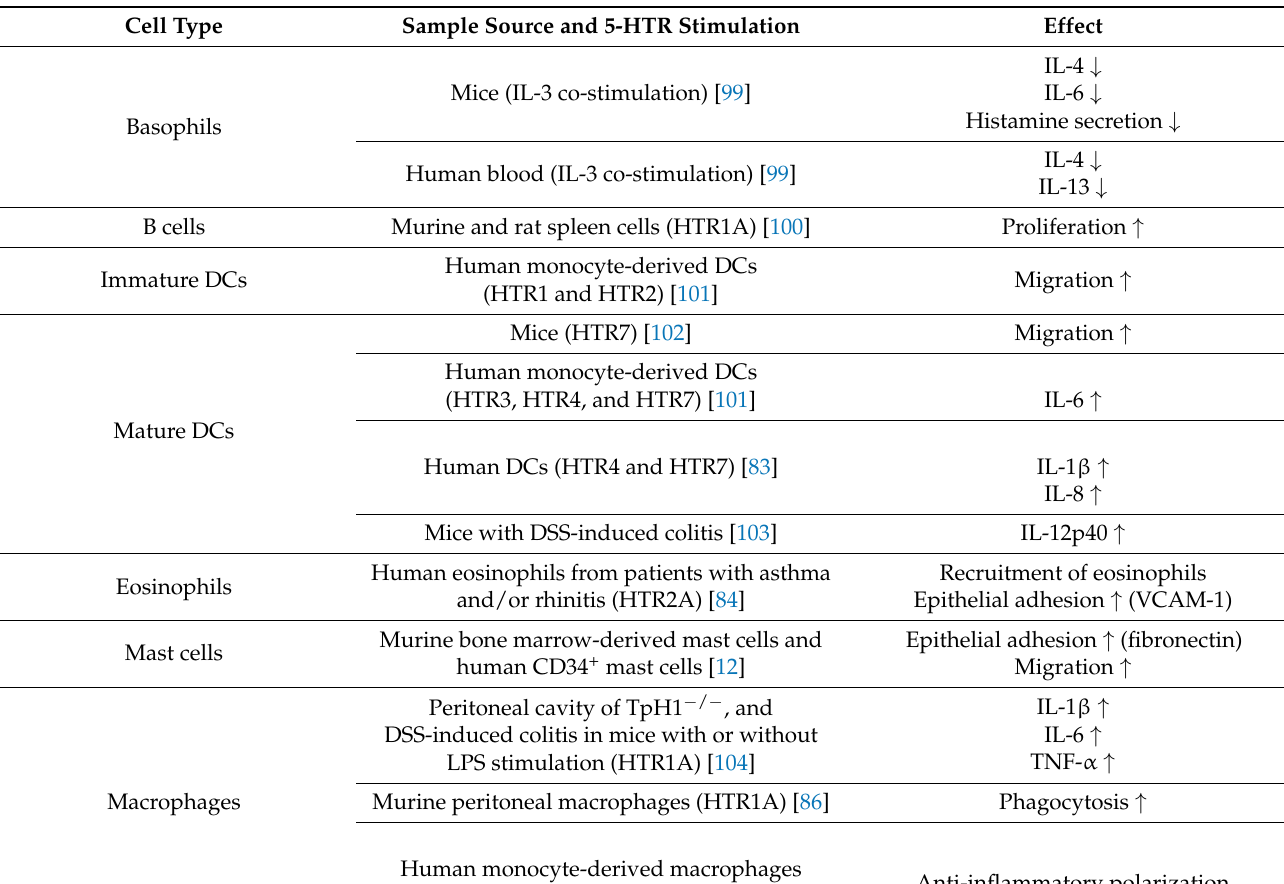
Table 4. Effects of HTR stimulation on immune and epithelial